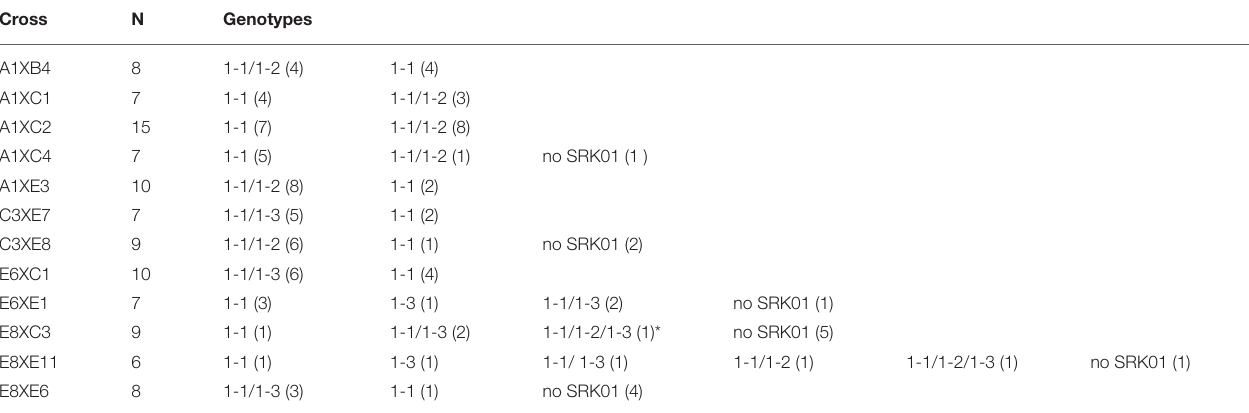
TABLE 5 | Segregation of SRK 01 genotypes within families raised from crosses between tetraploid A. lyrata individuals, as determined by direct Sanger sequencing; the number of individuals where a particular genotype was found is indicated in parentheses. Cross N Genotypes